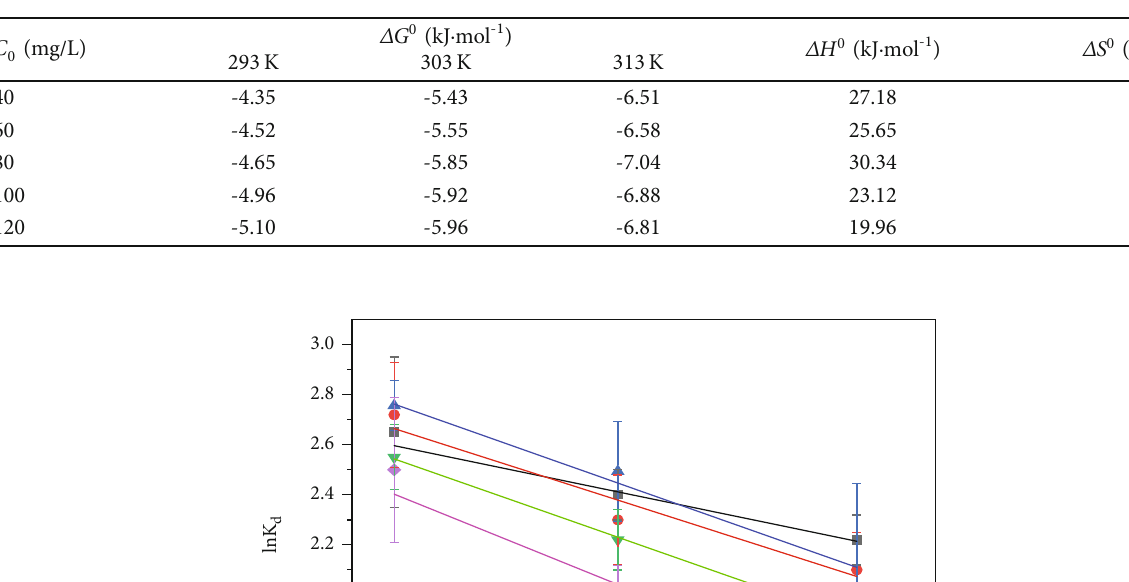
Table 4: Thermodynamic fi tting parameter table.